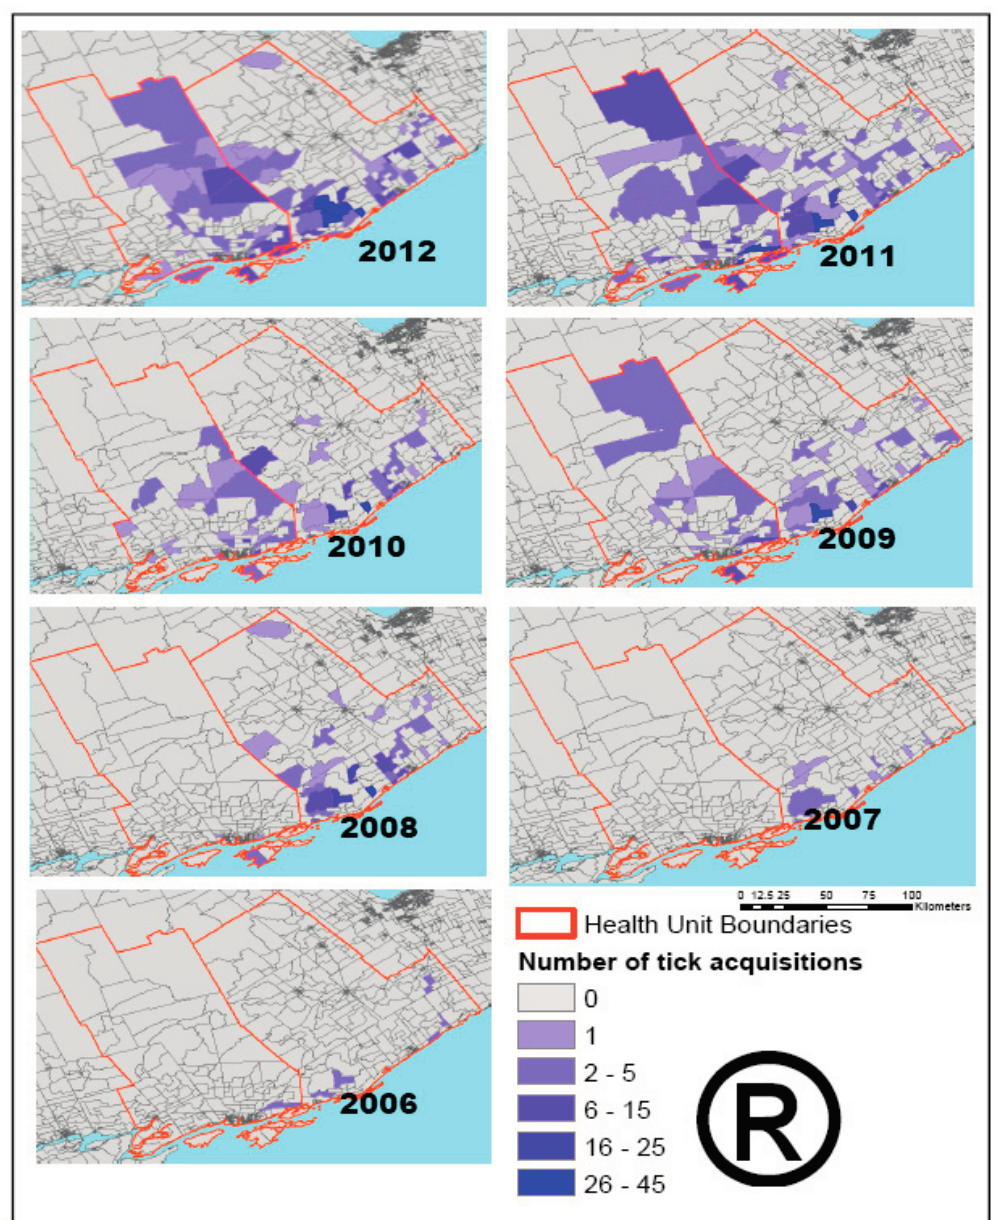
Figure 5. Distribution of Tick Acquisition by year from 2006 to